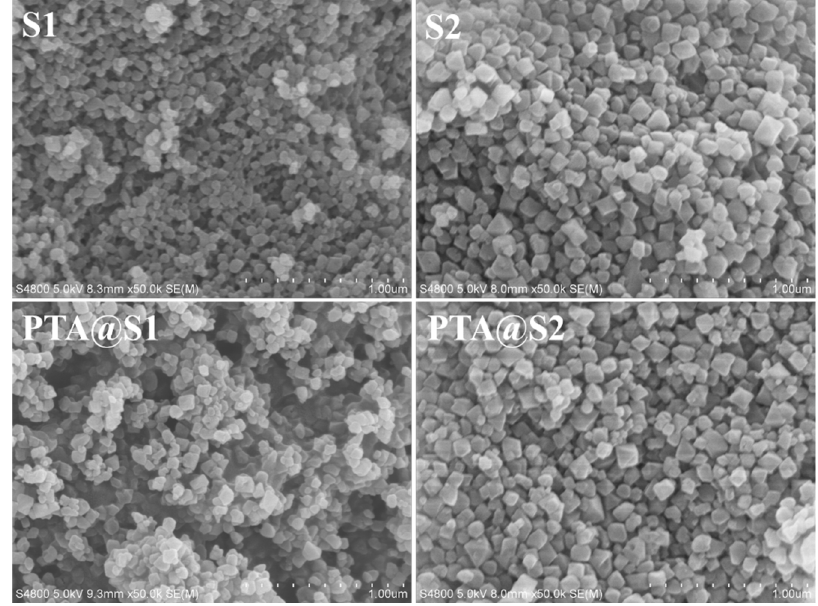
Figure 2. Scanning electron microscopy (SEM) images of S1, S2, PTA@S1 and PTA@S2.